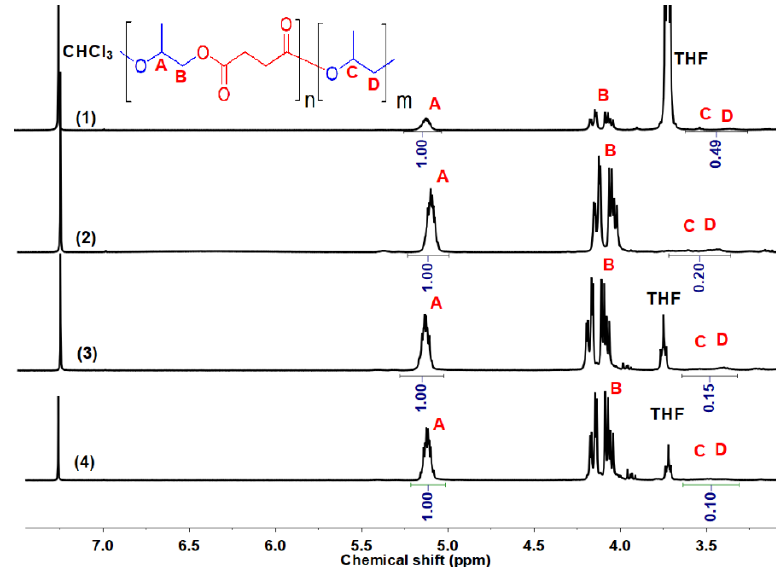
Figure 1. 1 H NMR spectra of crude products at different catalyst systems: (1) trimethylamine (TEA)